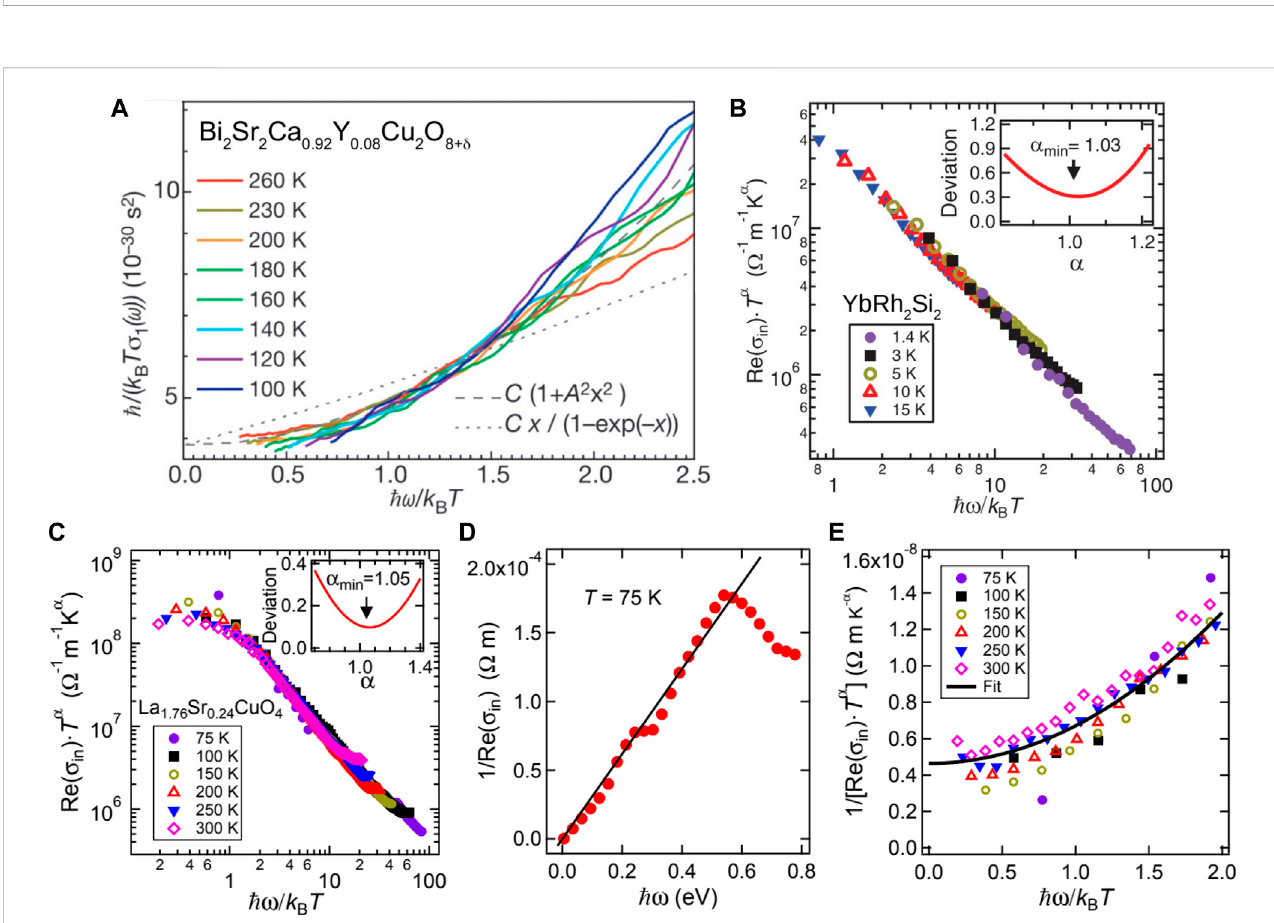
FIGURE 6 Energy-over-temperaturescalingofthe realpartoftheoptical conductivity of (A) thecuprateBi 2 Sr 2 Ca 0.92 Y 0.08 Cu 2 O 8+ δ and (B) an MBE fi lm ofYbRh 2 Si 2 . For the latter, the residual conductivity was subtracted as explained in (Prochaska et al., 2020). Note the different temperature and frequency ranges, above 100 K (above the compound ’ s superconducting transition temperature T c = 96 K) and 1.5 THz (far infrared) in the former, and above 1.4K and .23 THz (THz range) in the latter. In (C) we replot optical conductivity data of La 2 − x Sr x CuO 4 with x = .24 from (Michon et al., 2022), after subtracting the residual conductivity(seetext),inthesamekindofscalingplotasshowninpanel (B) .Usingdatabelow.6eV,thebestscalingcollapseisobtainedfor α ≈ 1(inset),justas for YbRh 2 Si 2 . (D) Optical resistivity 1/Re[ σ in ( ω )] at 75K, which is approximately linear in frequency up to .6 eV. (E) Fit of the scaled data from panel C with the scalingfunctionde fi nedinEqs17,19,asusedin(vanderMareletal.,2003)and(Michonetal.,2022).PanelAisadaptedfrom(vanderMareletal.,2003),panelB from (Prochaska et al., 2020). Data in panel (C – E) are taken from (Michon et al.,